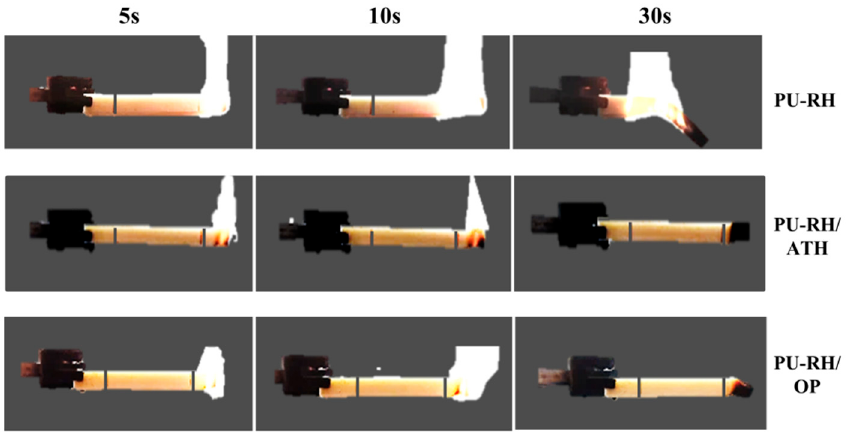
Figure 1. Images of the UL94 HB tests of PU–RH, PU–RH/ATH 125 , and PU–RH/OP 20 .